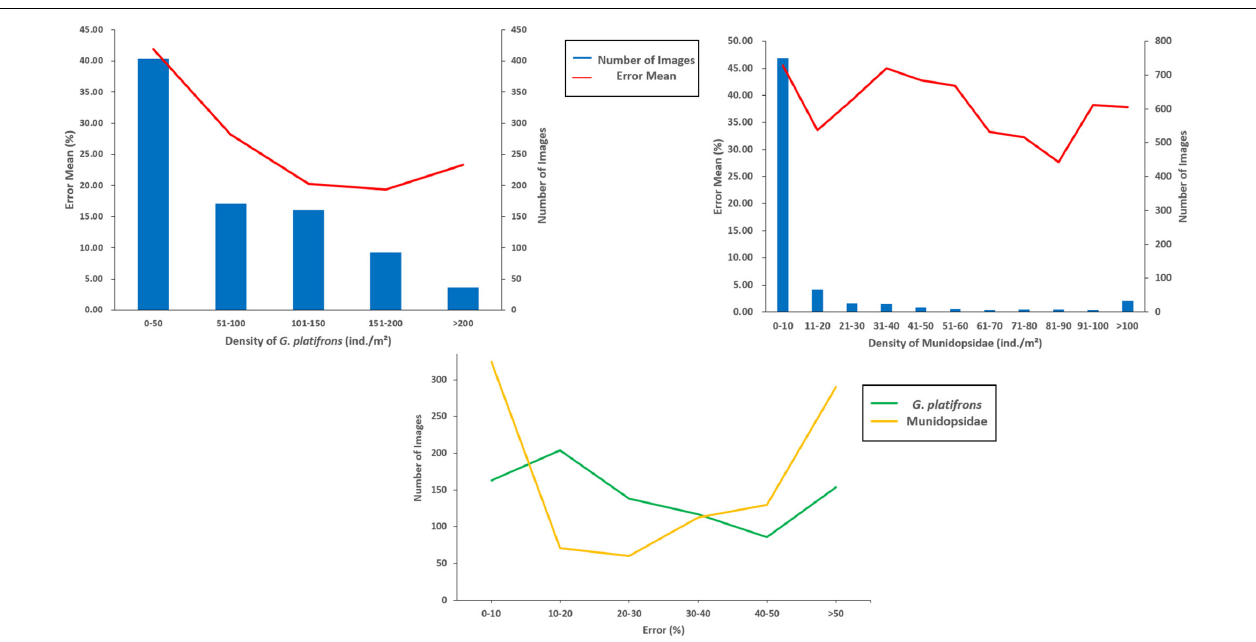
FIGURE 6 | Error mean for different densities about the dominant species and the number of images with different errors.